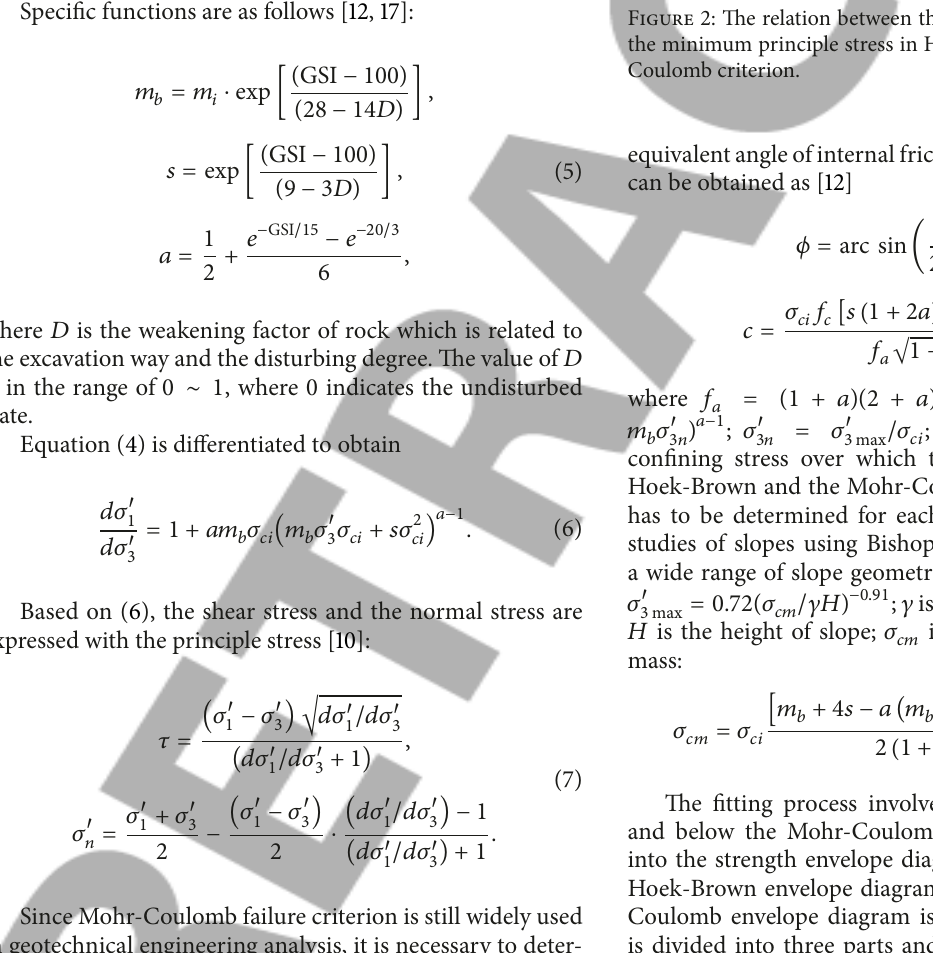
Figure 2: The relation between the maximum principle stress and the minimum principle stress in Hoek-Brown criterion and Mohr- Coulomb